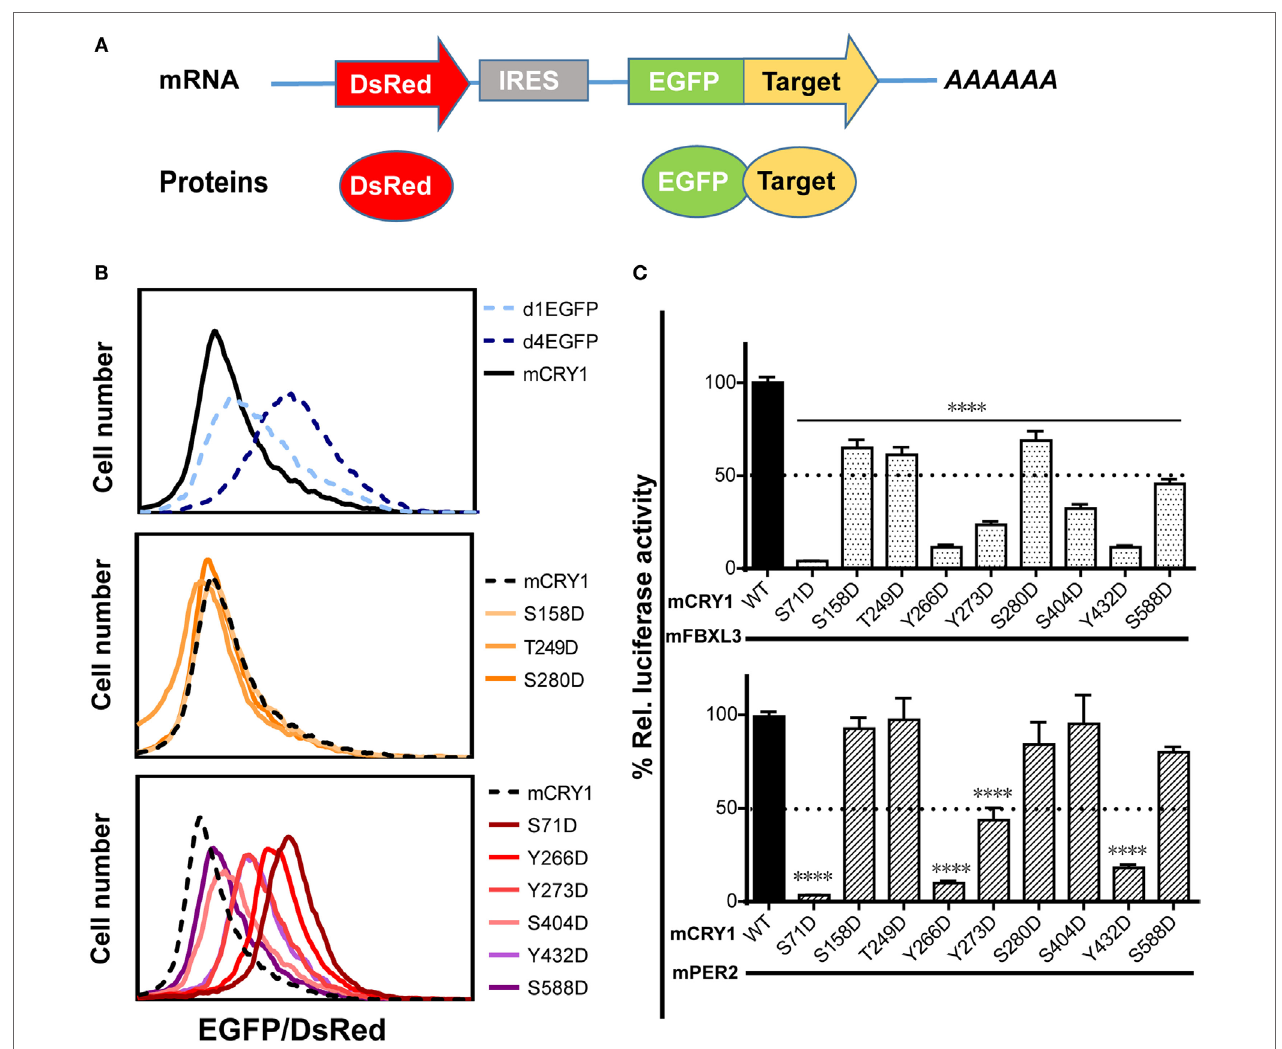
FigUre 3 | effects of phosphomimetic mutation on mcrY1 protein stability and interactions with FBXl3 and Per2 . (a) Global protein stability (GPS) reporter system. The DsRed–IRES–EGFP target element was cloned into a lentiviral vector, and the fluorescent reporter proteins were co-expressed from a single mRNA via an internal ribosomal entry site (IRES). (B) HEK293 cells were infected with lentivirus of pLv–DsRed–IRES–EGFP–mCRY1 (WT or mutant) for 24 h, and then the fluorescent protein signals were analyzed by flow cytometry. The EGFP/DsRed ratio acts as a reporter for stability of the expressed WT or mutant mCRY1. The d1EGFP and d4EGFP are markers for 1- and 4-h half-lives, respectively. (c) Luciferase complementation assay. mCRY1 (WT or mutant) and FBXL3 (or PER2) were co-expressed as fusion proteins with luciferase fragments in HEK293 cells. Experiments were done as in Figure 2a and the data presented relative to mCRY1 (WT)-mFBXL3 (or mPER2). Mean and error bars (SEM) of three independent transfections are shown (**** p < 0.0001, ANOVA). Two additional experiments gave similar